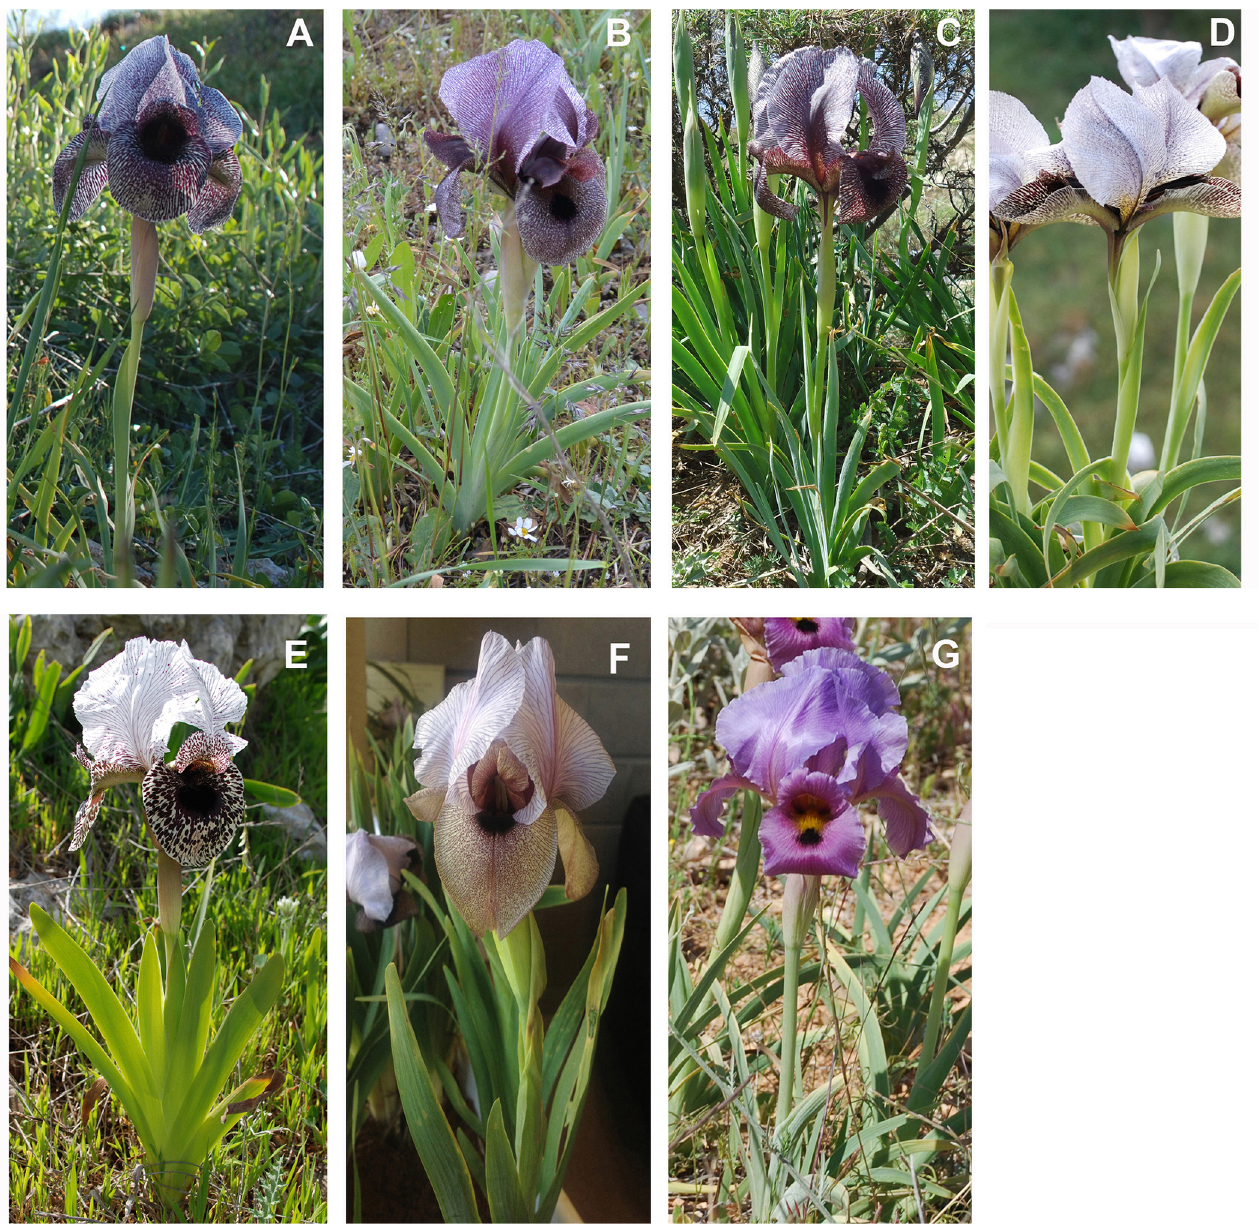
Fig 1. Diversity of Lebanese royal irises, illustrated by some of the studied taxa. A: Iris sofarana subsp. sofarana , B: I . sofarana subsp. kasruwana , C: I . cedreti , D: I . westii , E: I . bismarckiana , F: I . lortetii , G: I . antilibanotica . Photographs from M. Bou Dagher-Kharrat